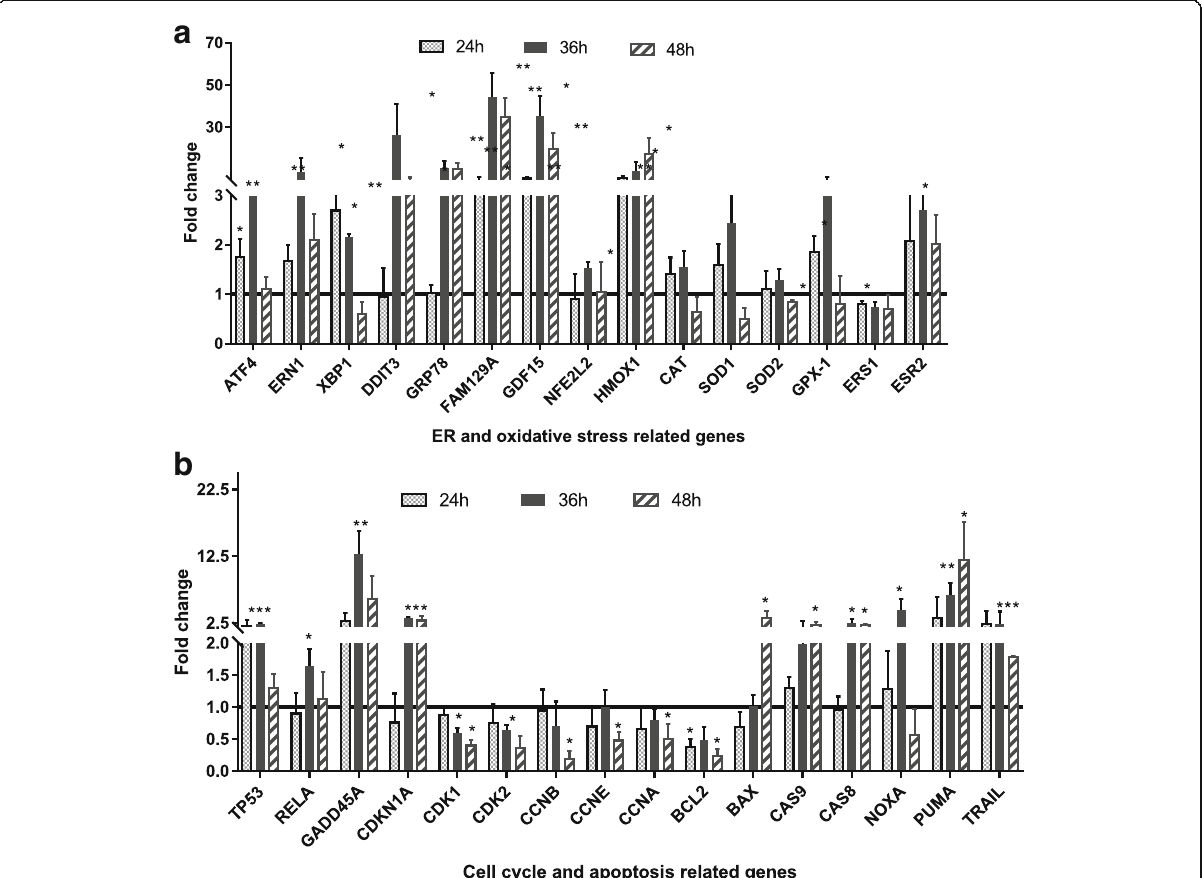
Fig. 2 Real-time RT-PCR analysis of gene expression level after treating MCF-7 cells with NDL for 24, 36 and 48 h. Fold change indicated relative quantitation normalized to GADPH. Fold change >1 and <1 indicated upregulation and downregulation, respectively. The statistical differences between the treatment and control conditions were analyzed by two-tailed paired Student ’ s t-tests (* p < 0.05; ** p < 0.01; *** p < 0.001). a , ER and oxidative stress related genes; b , cell cyle and apoptosis related